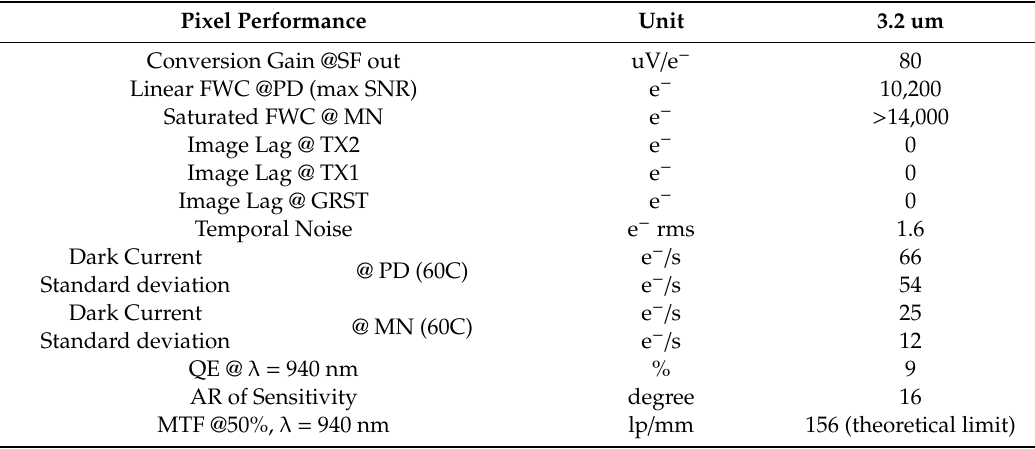
Table 5. Key pixel performances of 3.2 µ m GS pixel with stacked deep